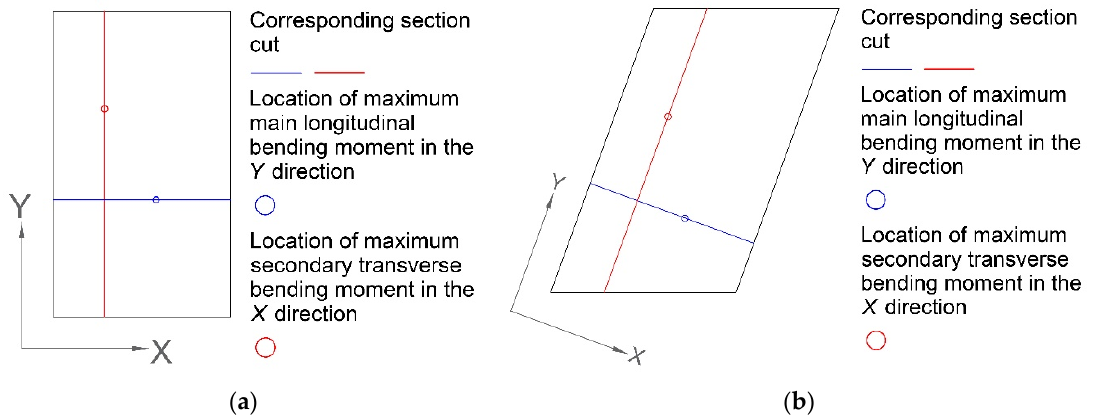
Figure 6. Main longitudinal and transverse moment section cuts for design. ( a ) Straight bridges and ( b ) skewed bridges.